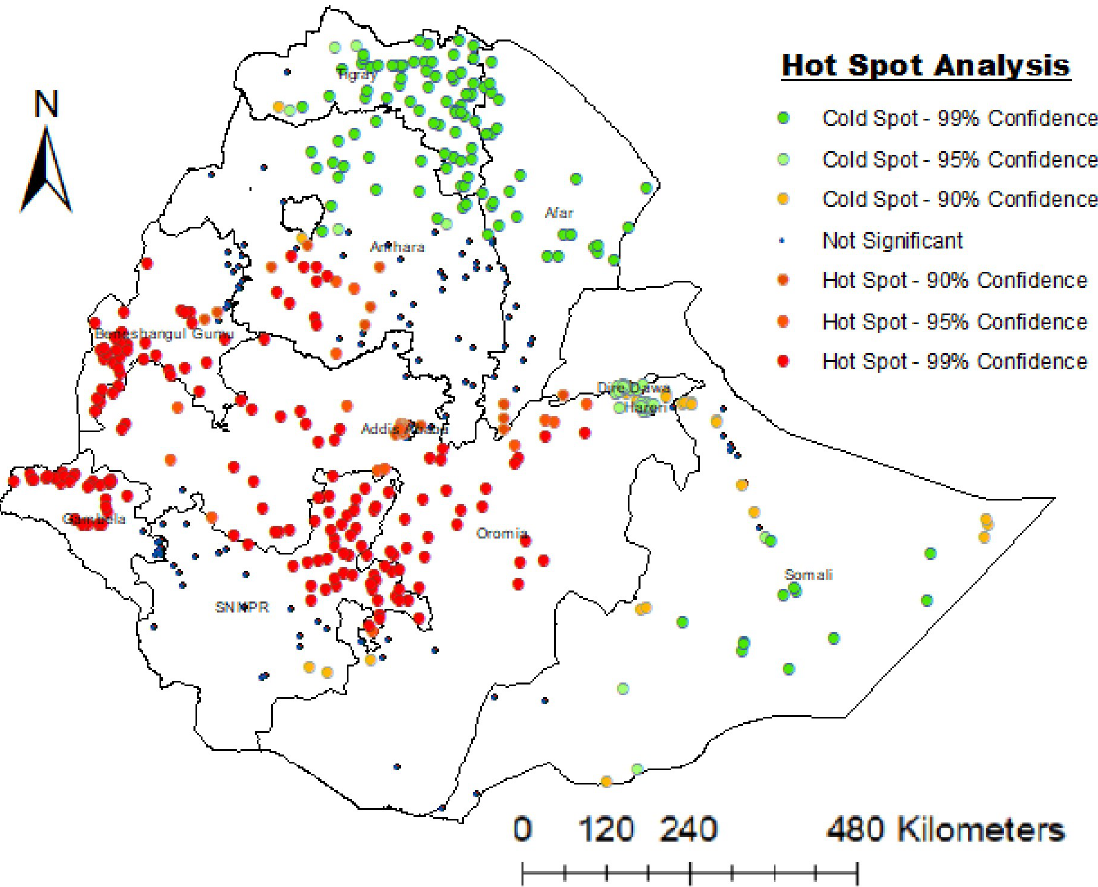
Fig 3. Hot spot and cold spot identification of unemployment women in Ethiopia, 2016 EDHS (Source of shapefiles: https:// africaopendata.org/dataset/ethiopia-shapefiles).